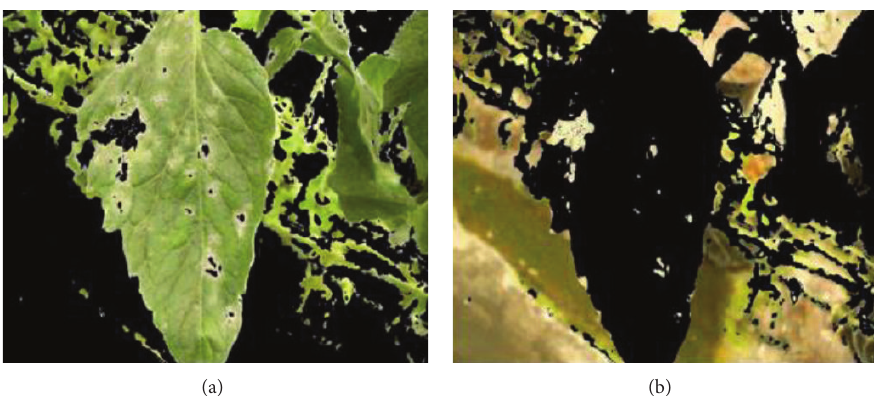
Figure 4: The resultant images by joining the different color groups. (a) The resultant image for the color groups labeled as vegetation and (b) the resultant image for the color groups labeled as